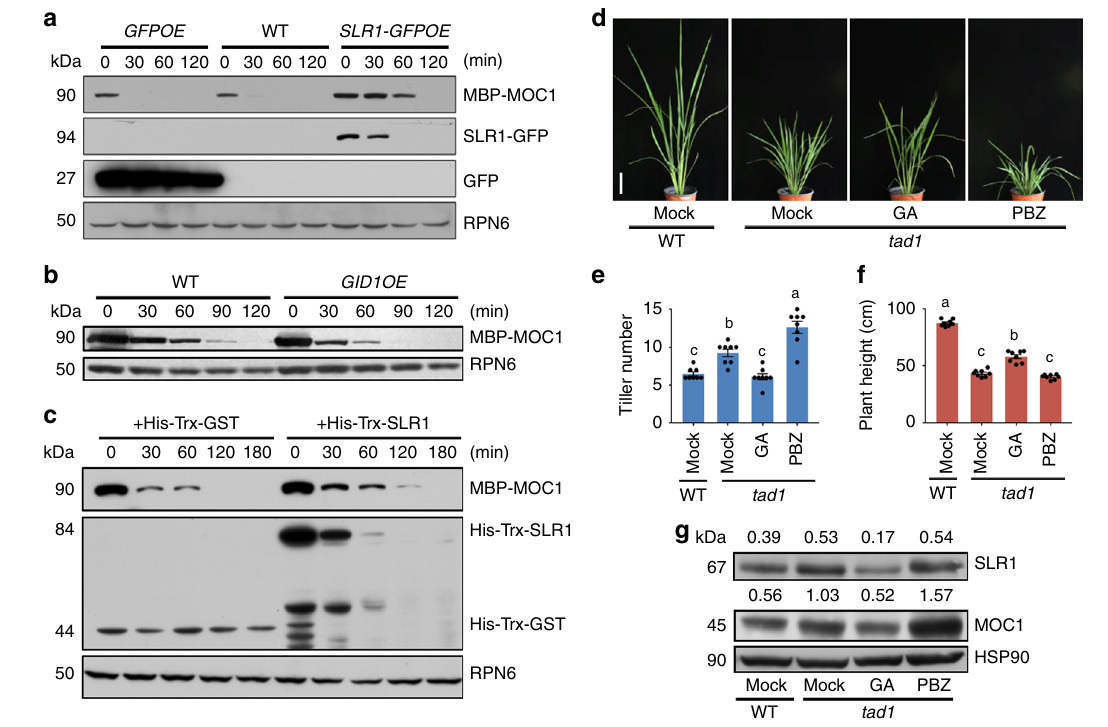
Fig. 4 SLR1 inhibits the degradation of MOC1 independently of TAD1. a In vitro cell-free protein degradation assay, showing degradation of MBP-MOC1 in extracts from WT, GFPOE and SLR1-GFPOE transgenic plants. Immunoblots were probed with anti-MBP ( α -MBP). Ribosomal protein 6 (RPN6), loading control. b In vitro cell-free protein degradation assay, showing degradation of MBP-MOC1 in extracts from WT and GID1OE transgenic plants. Immunoblots were probed as in ( a ). c In vitro cell-free protein degradation assay, showing that degradation of MBP-MOC1 was inhibited by His-Trx-SLR1, but not His-Trx-GST. Immunoblots were probed as in ( a ). d Effects of GA and PBZ treatments on tad1 . Scale bar, 10 cm. e , f Quanti fi cation of the tiller number ( e ) and height ( f ) of plants shown in ( d ). Different lowercase letters indicate signi fi cant differences (Tukey ’ s HSD test, p < 0.01; mean ± s.e.m., n = 8). g Immunoblot analysis of SLR1 and MOC1 proteins in shoot basal tissues (0 – 0.5 cm) after treatments. Tissue samples were analyzed by protein blotting using α -SLR1 and α -MOC1. HSP90, loading control. Values above panels indicate signal strength for SLR1 and MOC1 in arbitrary units determined by densitometry. The full scans of immunoblots are shown in Supplementary Fig. 12. Source data are provided as a Source Data fi